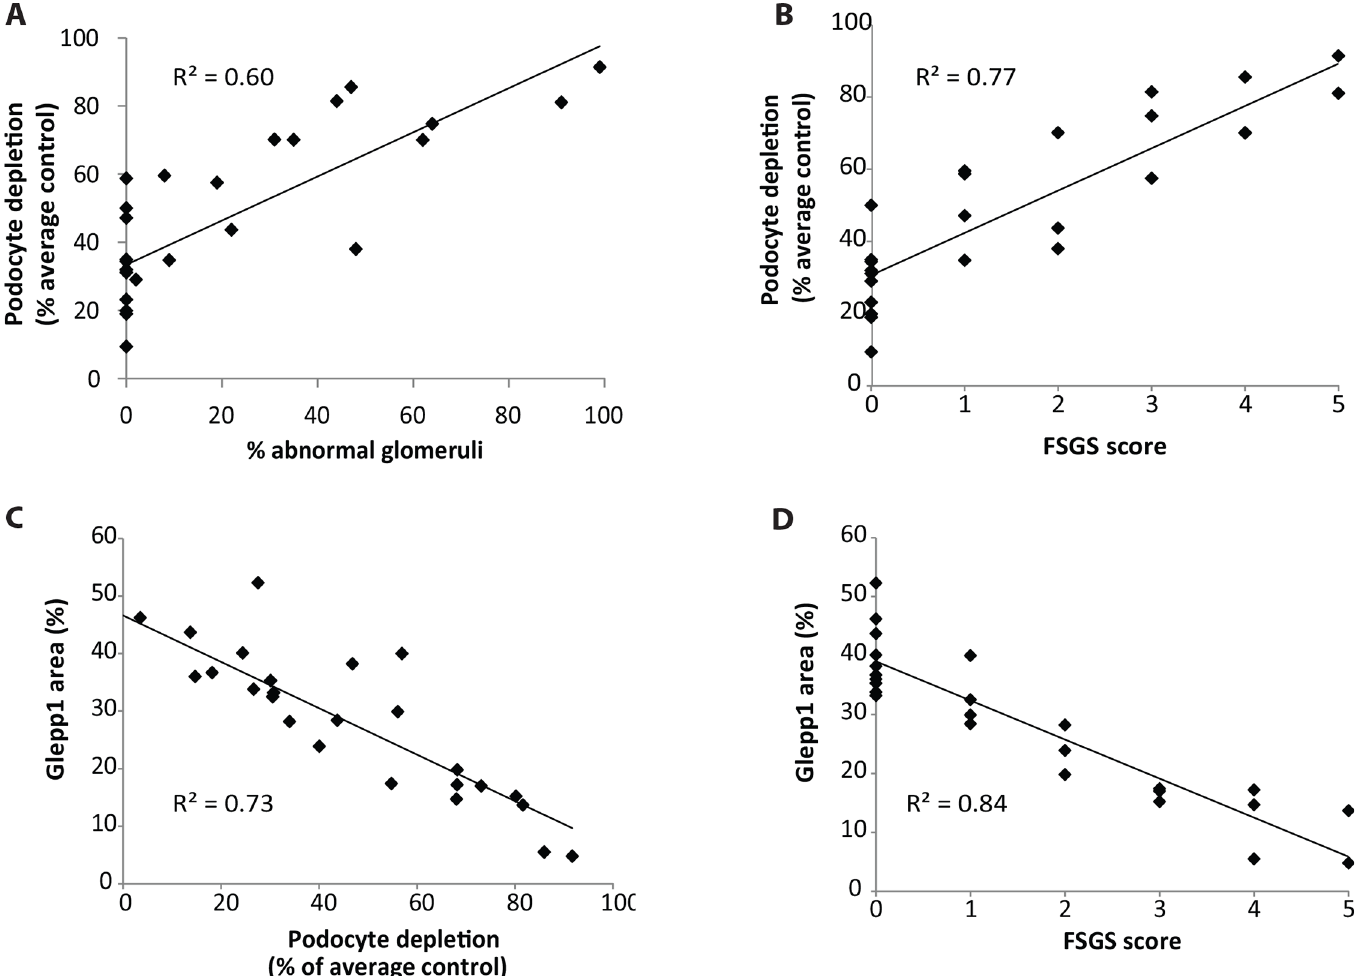
Fig 4. Histologic parameters increase in proportion to podocyte depletion. Panel A: The proportion of histologically detectable abnormal glomeruli present in a biopsy increases linearly in relation to the decrease in podocyte number per glomerulus after approximately 30% of podocytes have been lost. Panel B: Biopsies are scored as within normal limits (score 0), mesangial expansion only (score 1), or adhesions to Bowman ’ s capsule (score 2) or FSGS affecting < 10% of glomeruli (score 3) or FSGS affecting > 10% of glomeruli (score 4) or widespread glomerulosclerosis and interstitial fibrosis (score 5) increases. As the degree of podocyte depletion increases above 30% the histologic injury score increases. Note that no glomerular changes are present below 30% depletion, minor glomerular changes are associated with < 50% depletion, major glomerular changes (FSGS and global glomerulosclerosis) are present above 50% podocyte depletion. Panel C and D: The Glepp1 area % as an alternative method of measuring podocyte density is highly correlated with the % podocyte depletion (R 2 = 0.73) and FSGS scoring (R 2 = 0.84). Spearman correlation coefficients are used in all panels.